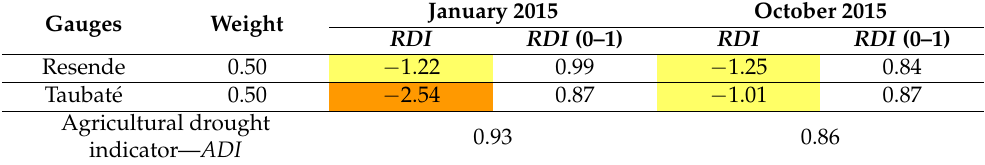
Table 9. Agricultural drought indicator (ADI ) application.